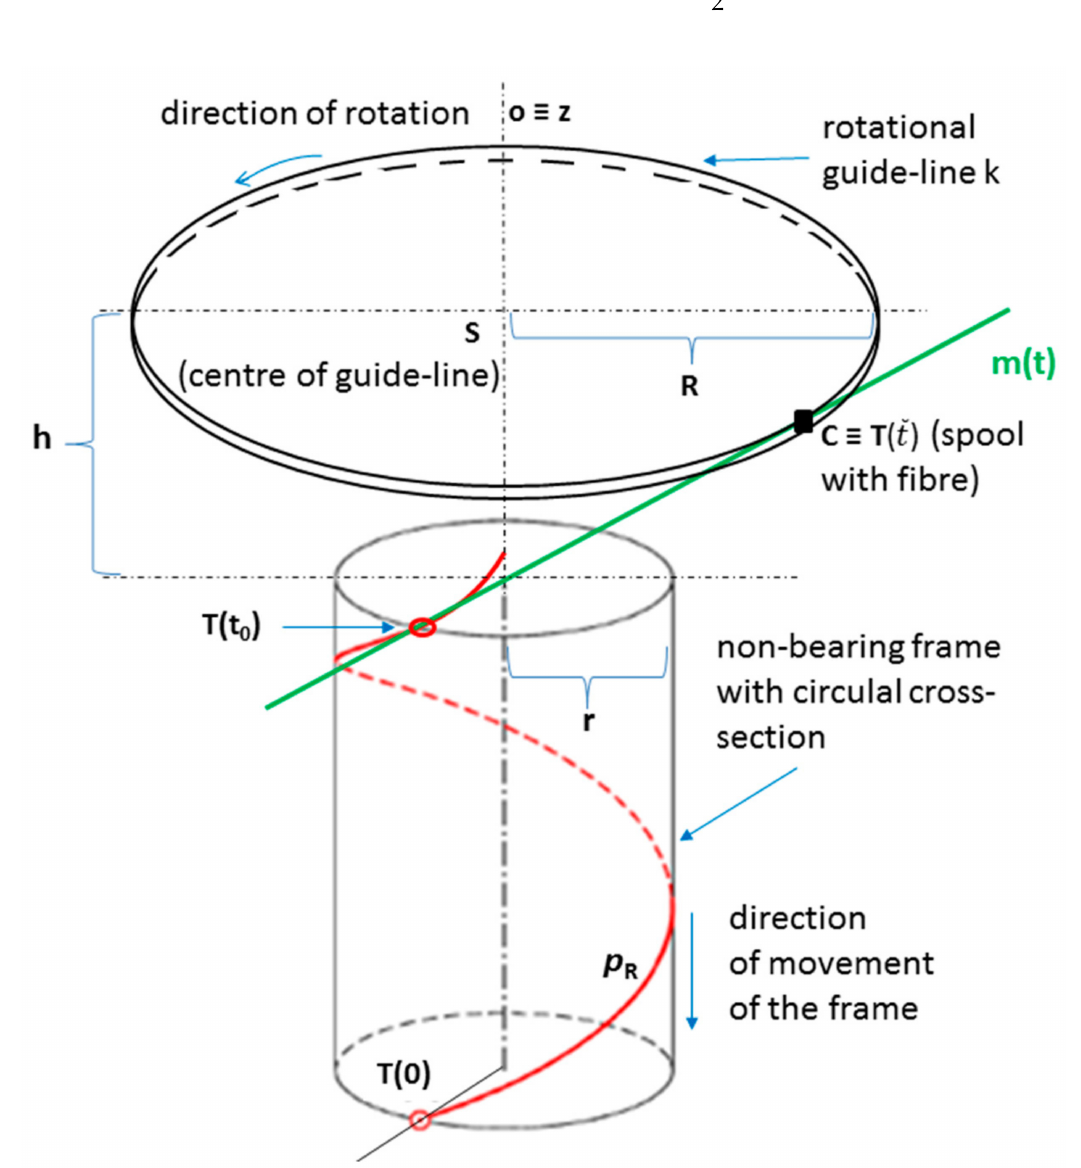
Figure 5. Schematic representation of the winding of a fiber by means of a rotation guide-line k of the fiber-processing head on a frame with a circular